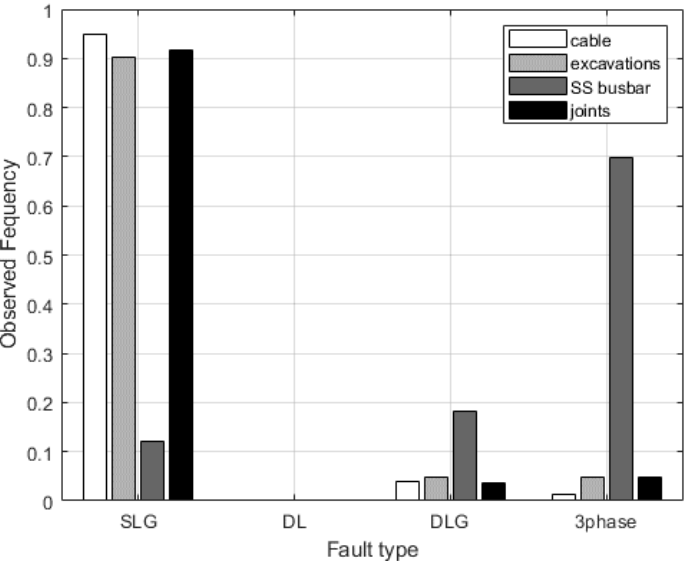
Figure 3. Example for the observed frequency of fault types for the various failure types. SLG, single line to ground fault; DL, double line fault; DLG, double line to ground fault; 3phase, three-phase fault.